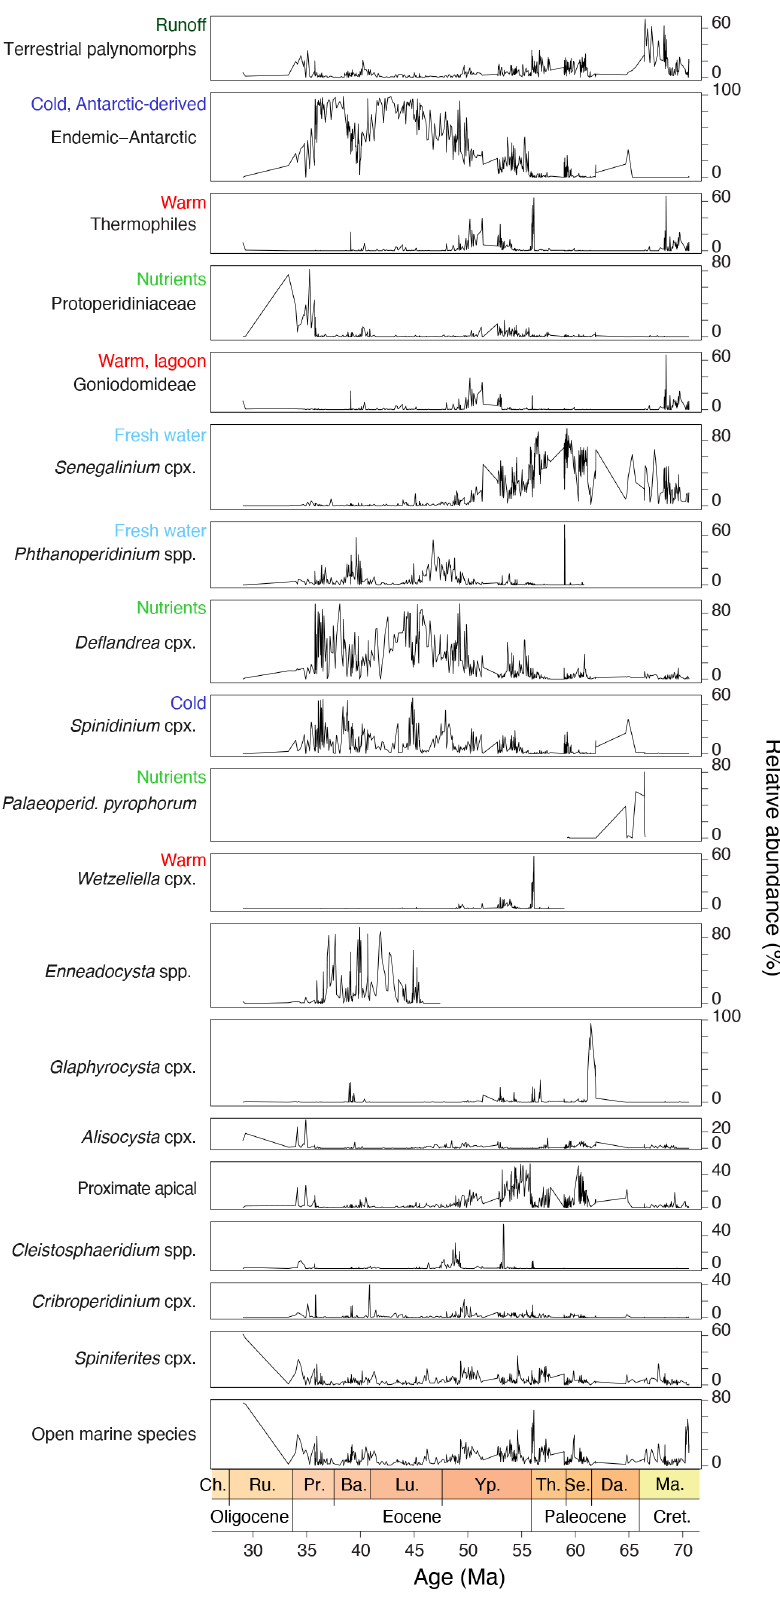
Figure 13. Dinocyst eco-groups and %terrestrial palynomorphs from Site 1172. From left to right, eco-groups are ordered in an inshore-to- offshore transect. Relative abundance ticks represent